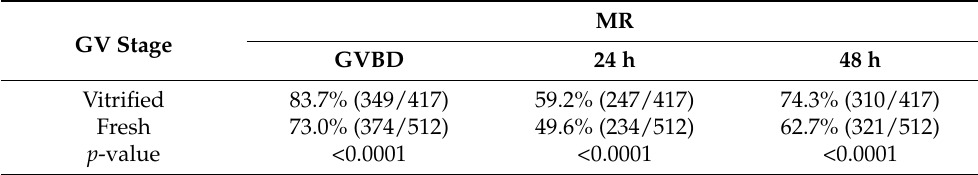
Table 1. Maturation rates (MR) evaluated relative to the maturation stage prior to vitrification in the groups studied (GV vitrified and GV fresh). MR in relation to germinal vesicle breakdown (GVBD) after 24 h (24 h) and 48 h (48 h) in culture. Average percentage by group and p -value. MR GV Stage GVBD 24 h 48 h Vitrified 83.7% (349/417) 59.2% (247/417) 74.3% (310/417) Fresh 73.0% (374/512) p -value <0.0001 <0.0001